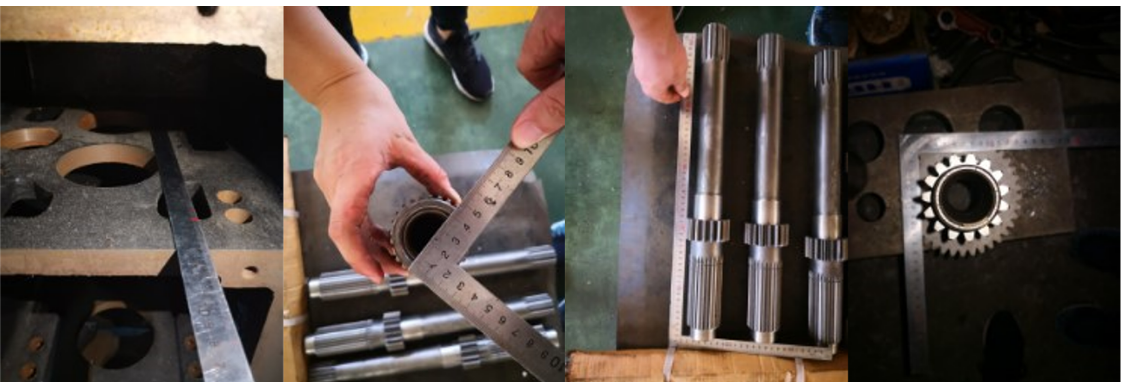
Figure 20. Measurement process of some parts.